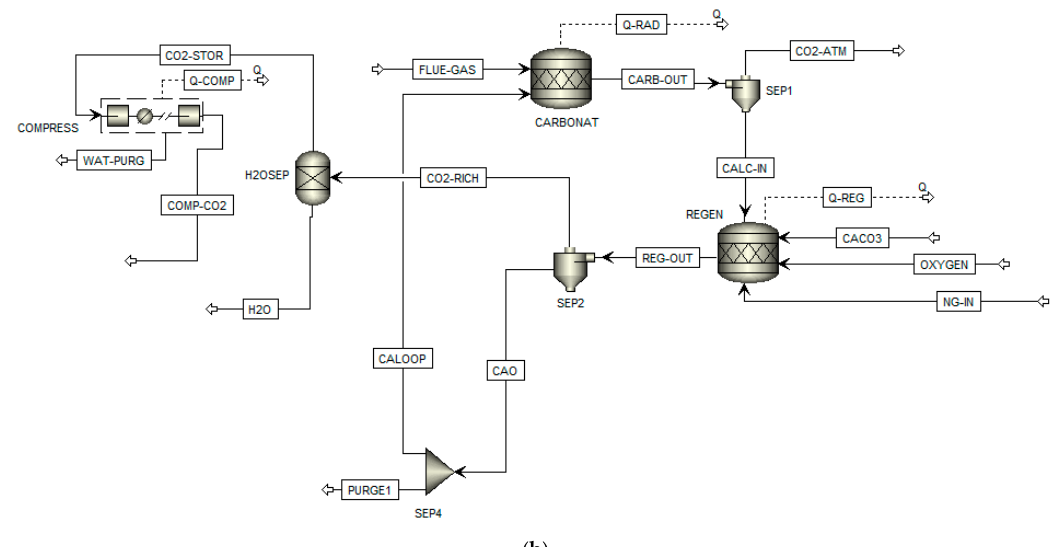
Figure 2. Calcium Looping system ( a ) coupled to a coal-fired thermoelectric plant, and; ( b ) coupled to a natural gas -fired thermoelectric power unit. 241